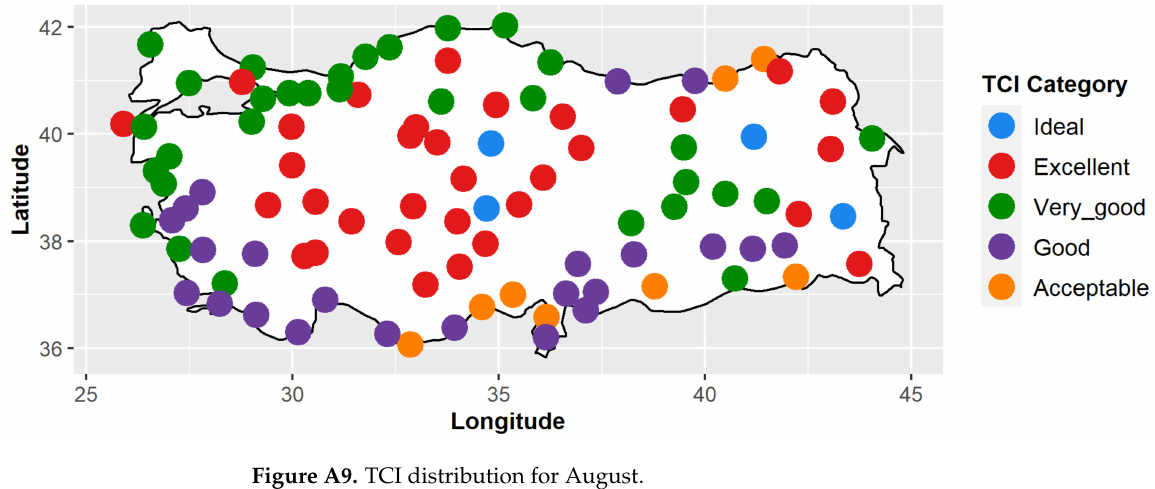
Figure A9. TCI distribution for August.